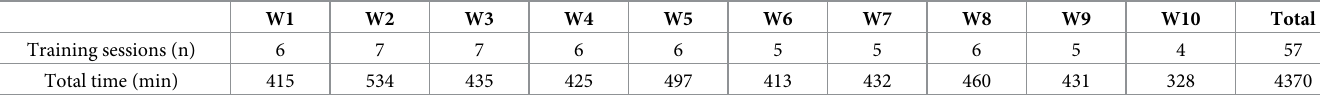
Table 1. Training sessions and time of training week during the 10-week